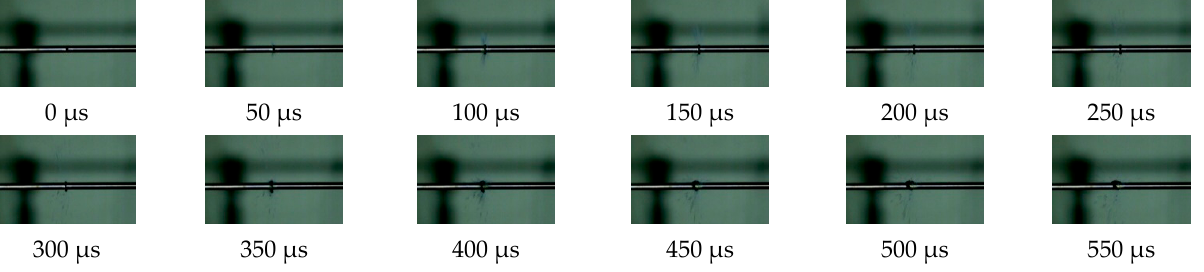
Figure 7. The middle part of PLA is broken (Strain rate is 10,200 s − 1 ).